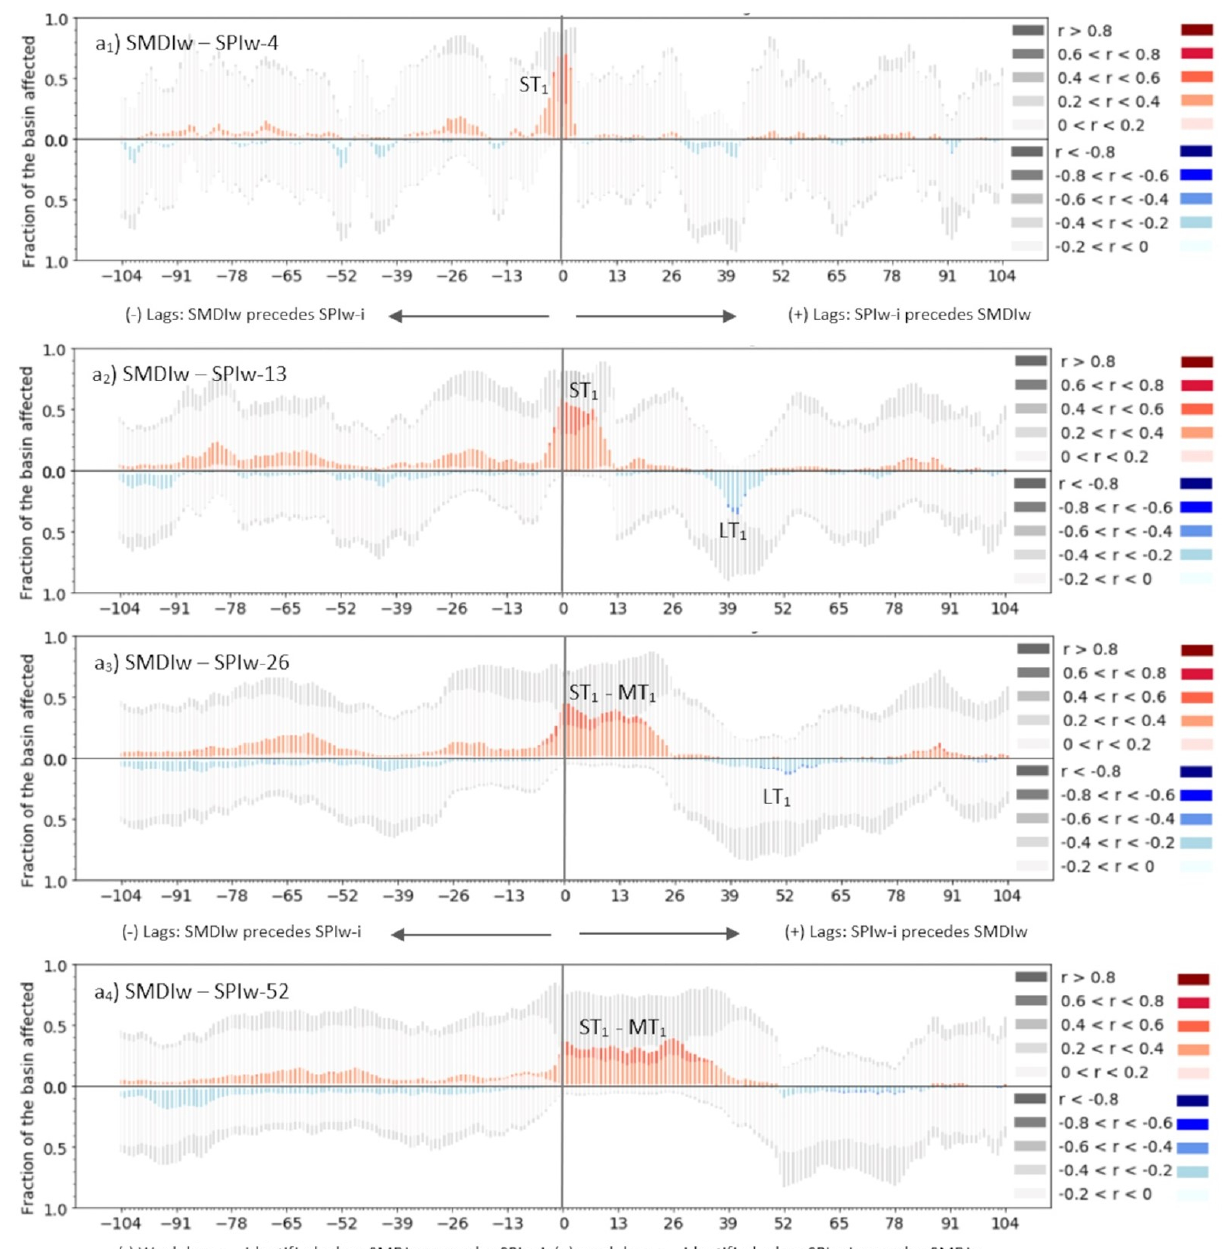
Figure 5. Lag plots of SPI-1, SPI-3, SPI-6 and SPI-12 (expressed as SPIw-4, SPIw-13, SPIw-26 and SPIw-52, respectively) with the remote sensing (RS) SMDIw index at the weekly scale for the period 2010–2017. Lags are calculated for the − 104 leading and + 104 lagged time steps of SMDIw in reference to SPIw- i . The height of the bars of the plot indicates the area of the basin affected by non-significant (greyscale) or significant (colored scale) correlations. The saturation of the colored scale indicates the magnitude of the significant positive (red) or negative (blue) Pearson correlation coefficient of SPIw- i and